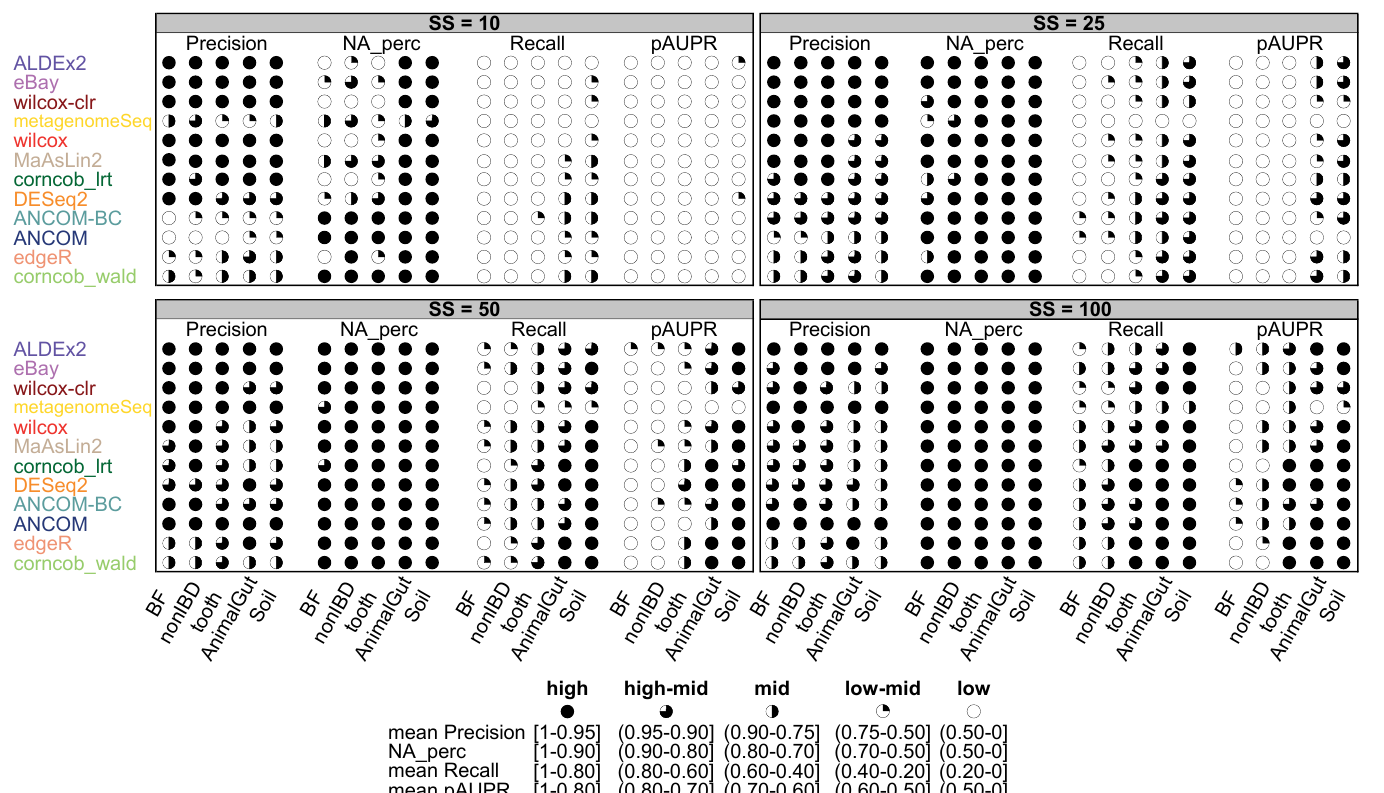
Fig 12. Overall performance of each DA method. In each set of boxes corresponding to different sample size (SS) values, Precision, NA_perc (percentage of available precision), Recall and pAUPR scores are shown for each dataset in columns. Methods (on rows) are ranked based on Precision values across all the SS scenarios and then based on Recall in case of ties. The legend below the boxes explains the threshold used to assign the overall score for each metric.